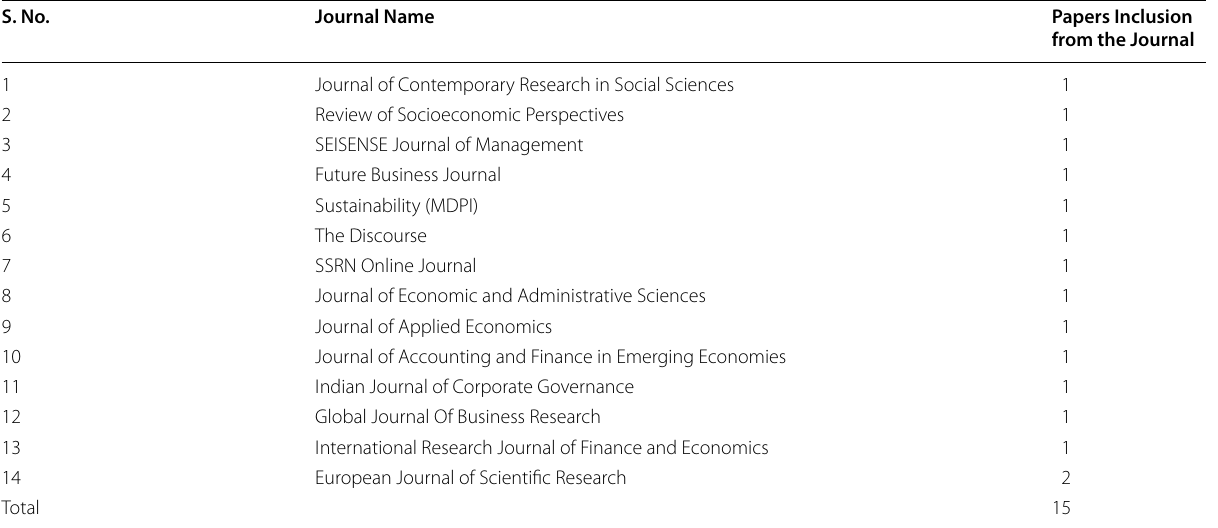
Table 3 International and other Journals taken from Google Scholar Research Papers S.